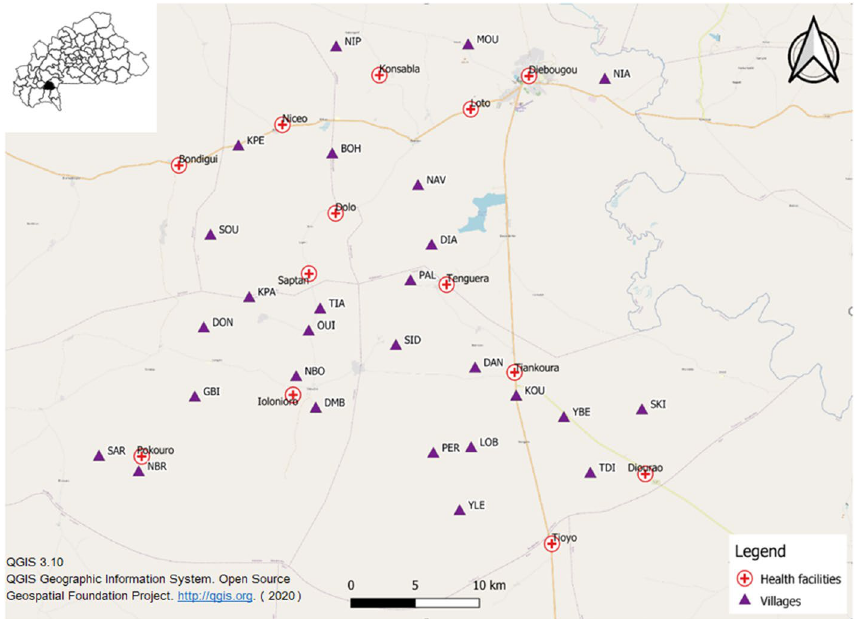
Figure 1. Map of the study area showing the location of villages (triangles) and health centres (red crosses). Background: OpenStreetMaps. MOU moule, NIA niaba, NIP nipodja, BOH bohero, NBR niombripo,